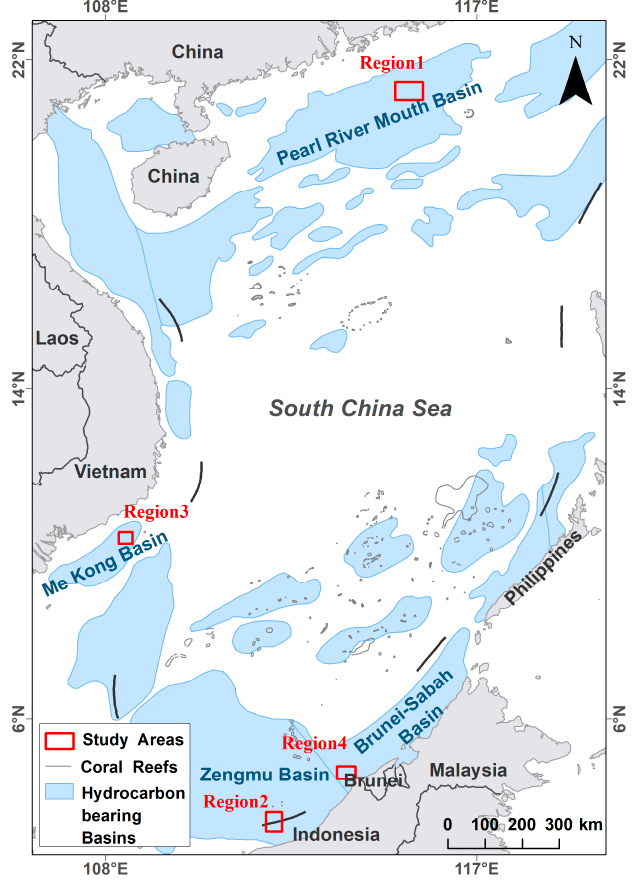
Figure 1. Study area. The red rectangle indicates the selected experimental